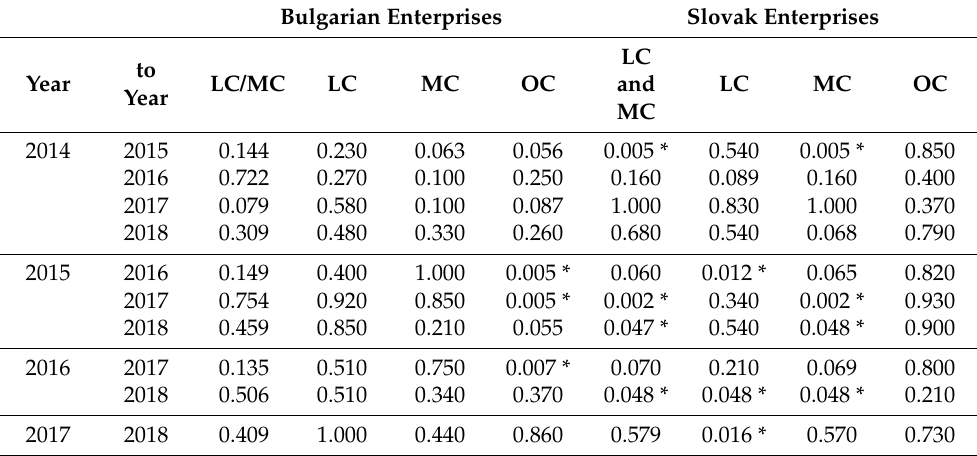
Table 4. p -values of t -test for the year-to-year differences in CCR scores, α =